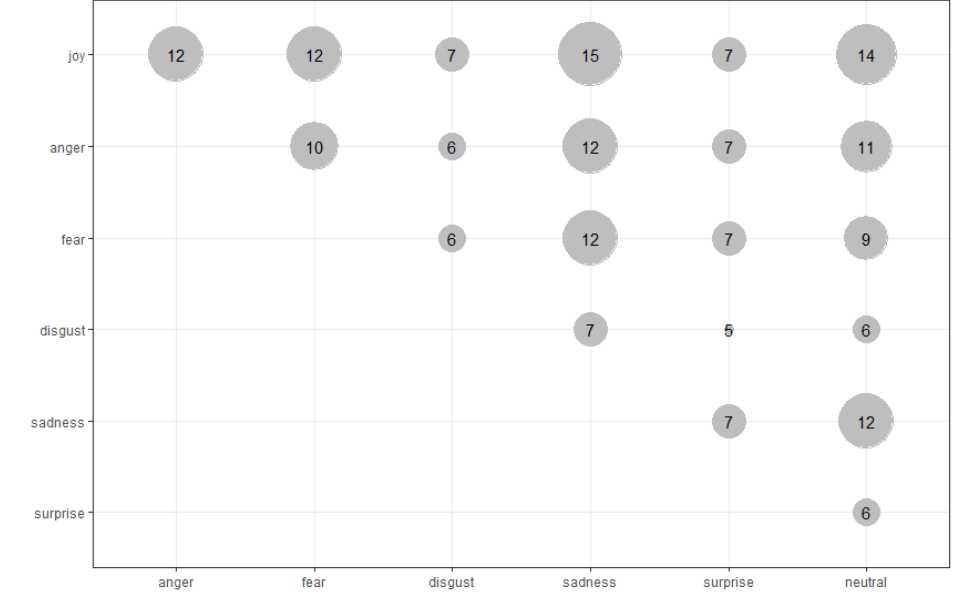
Figure 3. Co-occurrence of basic emotions in recognition